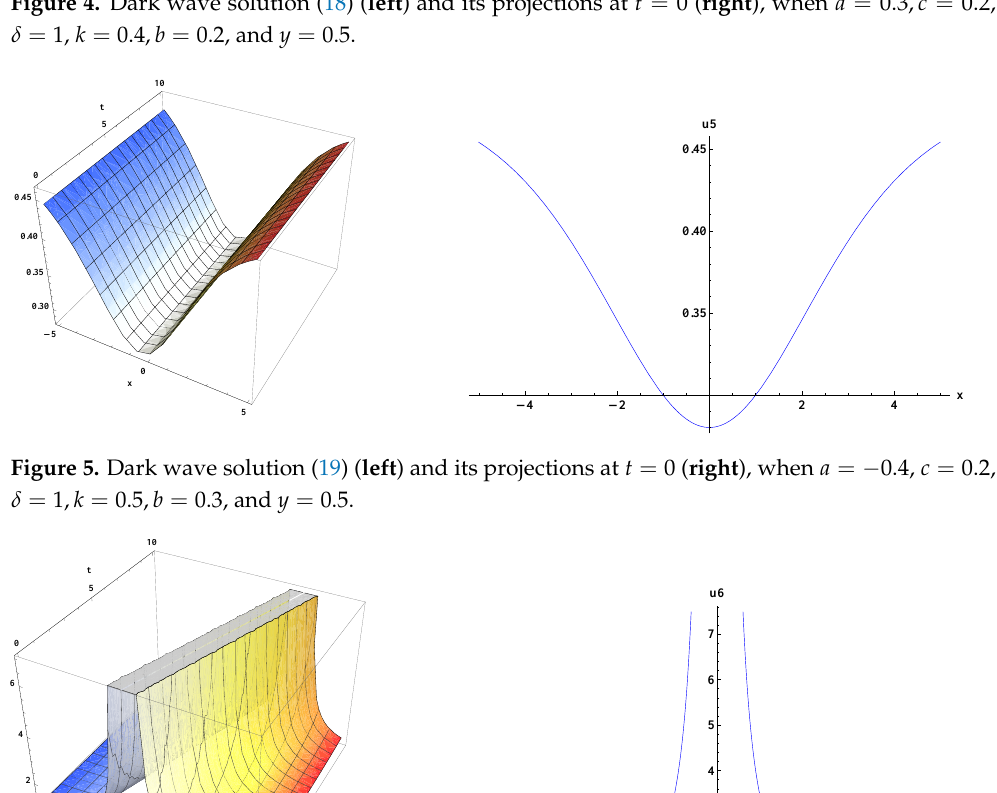
Figure 4. Dark wave solution (18) ( left ) and its projections at t = 0 ( right ), when a = 0.3, c = 0.2, δ = 1, k = 0.4, b = 0.2, and y = 0.5.